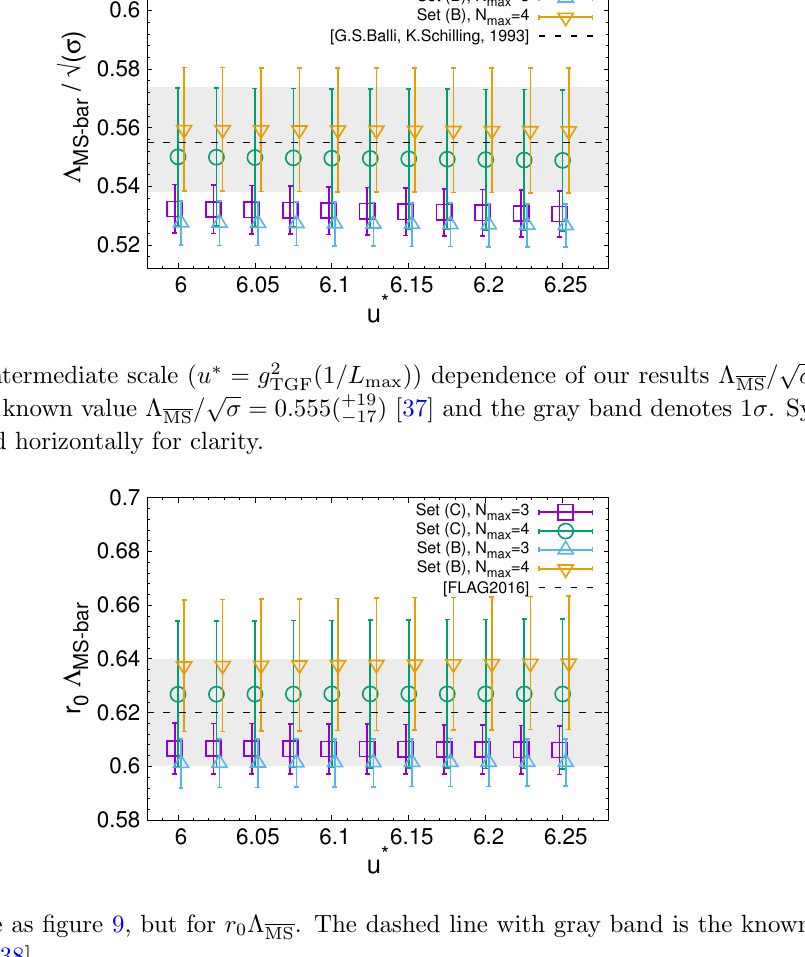
Figure 10 . Same as (cid:12)gure 9, but for r 0 (cid:3) r 0 (cid:3) = 0 : 62(2) MS